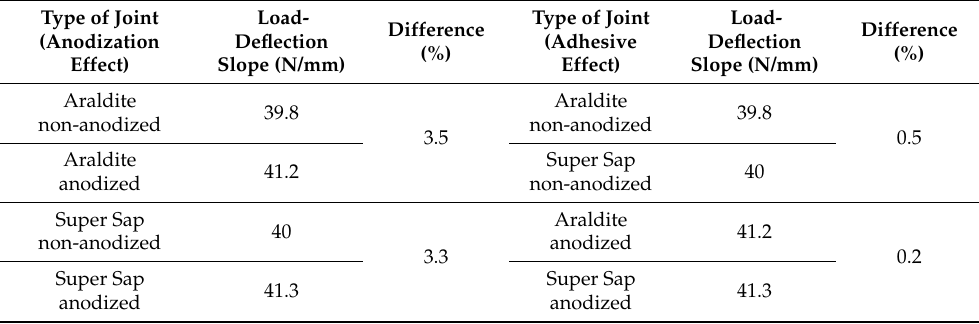
Figure 10. Bar diagram for the average load-deflection curves initial slope values of all the four types of joints manufactured and tested. Table 6. Comparison of the three-point bending average load-deflection curves initial slope values for the different types of aluminum single-lap joints.